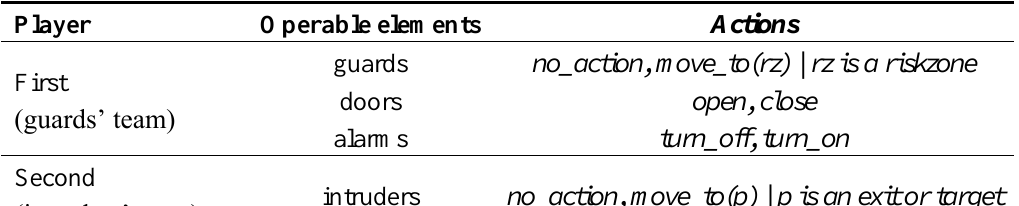
Table 1. Operable elements per player and the set of actions over